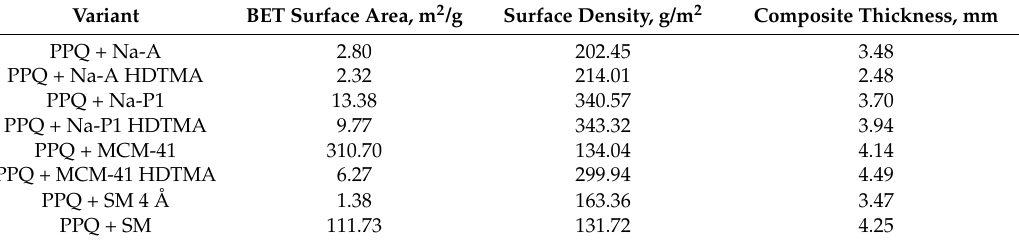
Table 2. Basic textural parameters of the produced nonwoven composites.